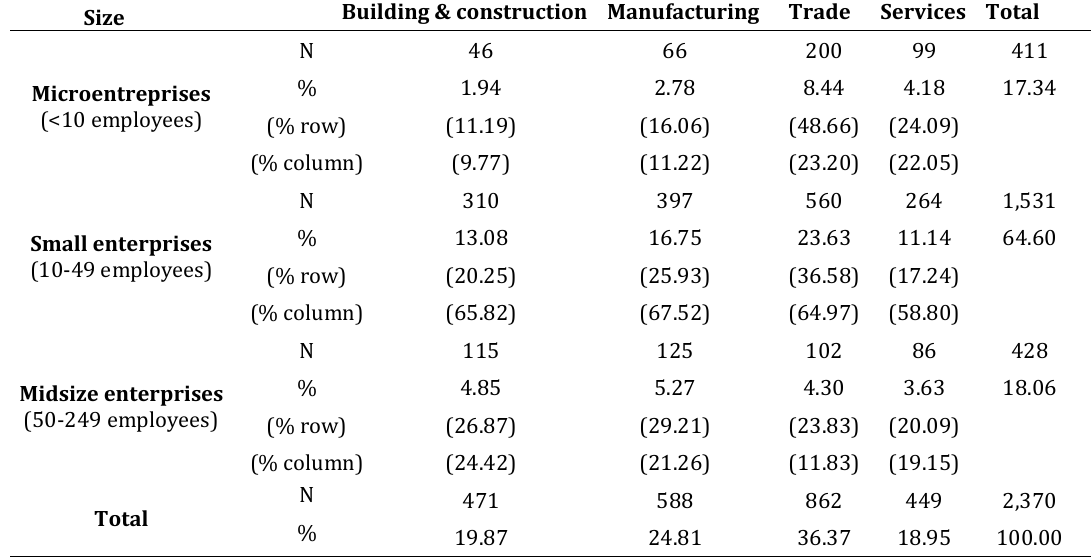
Table A2. Distribution of SMEs by size according to industry (year